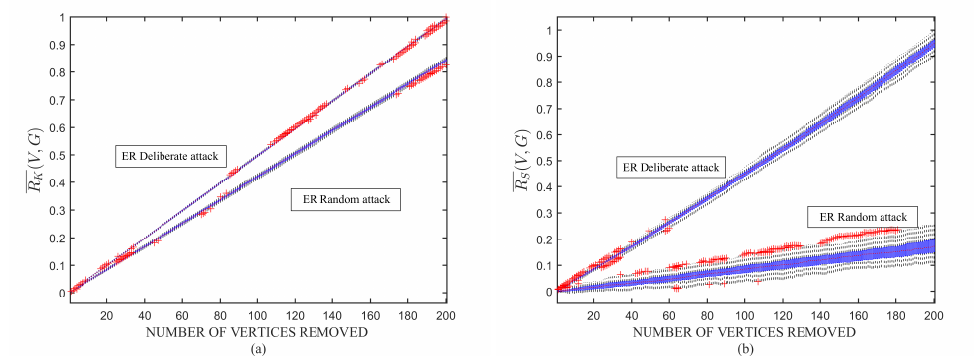
Figure 4. Experimental results for both measures when the number of removed vertices on the ER network reaches 200. Both are normalized data. ( a ) Deliberate and random attacks under the use of R K measures. ( b ) Deliberate and random attacks under the use of R S